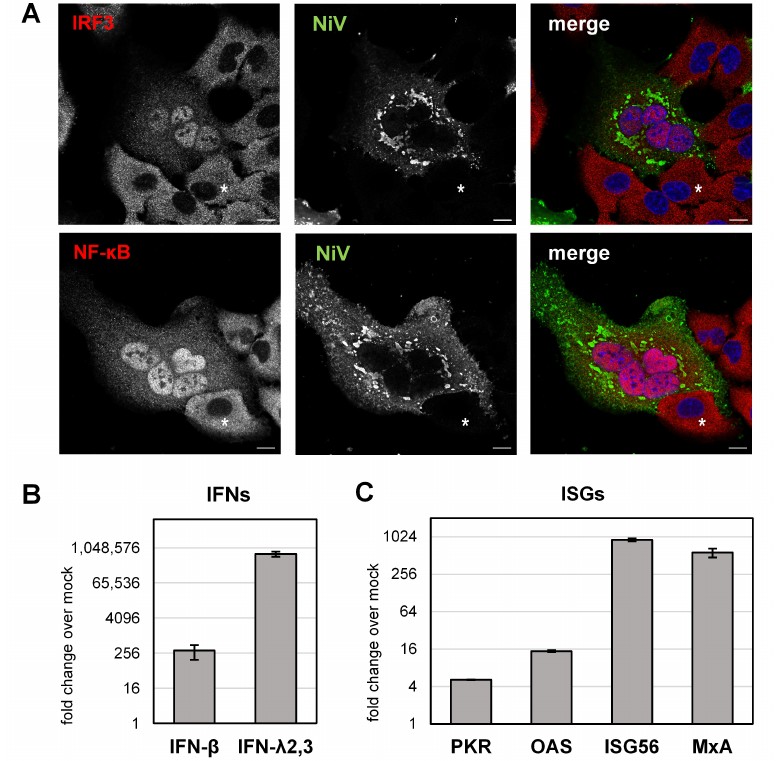
Figure 5. IFN upregulation and ISG expression in NiV-infected cell cultures. ( A ) A549 cells were infected with NiV at an MOI of 10. At 24 h p.i., cells were fixed with PFA, permeabilized with